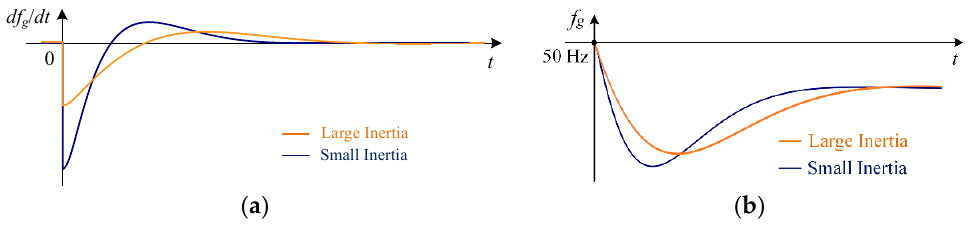
Figure 4. Grid frequency response with different inertia values. ( a ) Comparison of RoCoF. ( b ) Comparison of grid frequency.